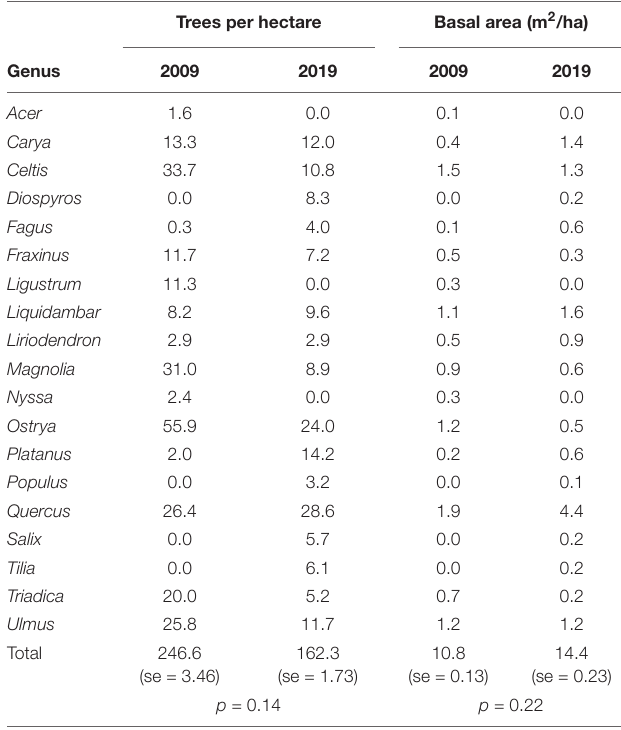
TABLE 1 | Univariate statistics for abundance of overstory trees after hurricane damage and salvage logging in 2009 and 2019 ( n = 40). Trees per hectare